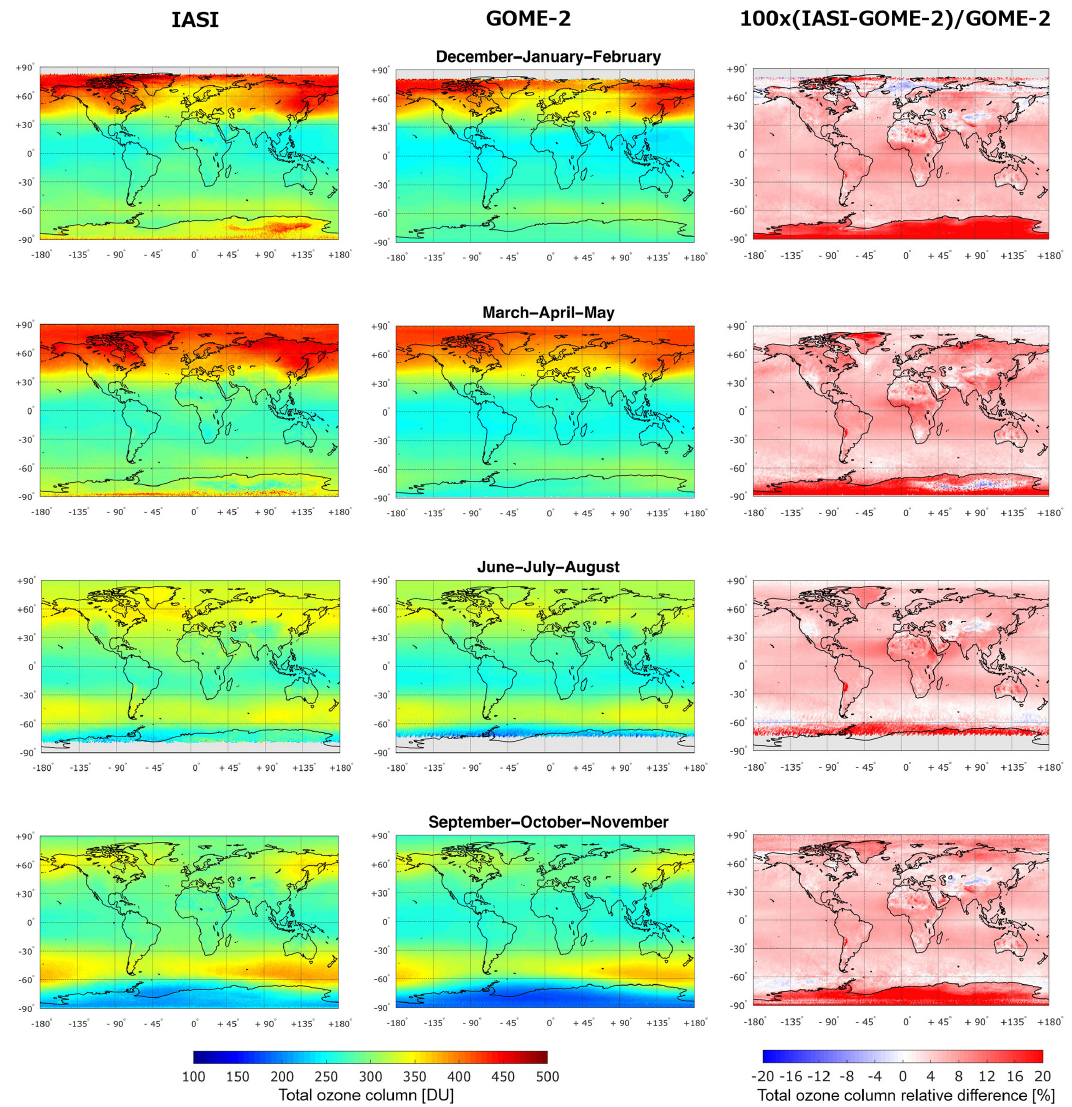
Figure 6. Global distribution for three months averaged periods (1 ◦ × 1 ◦ grid) between 2008 and 2014: (left) IASI-A total ozone column compared to (middle) GOME-2A O3M SAF retrieved total ozone columns for daytime observations. The relative differences (in percent) calculated as (IASI-GOME2) / GOME2 × 100 are displayed on the right